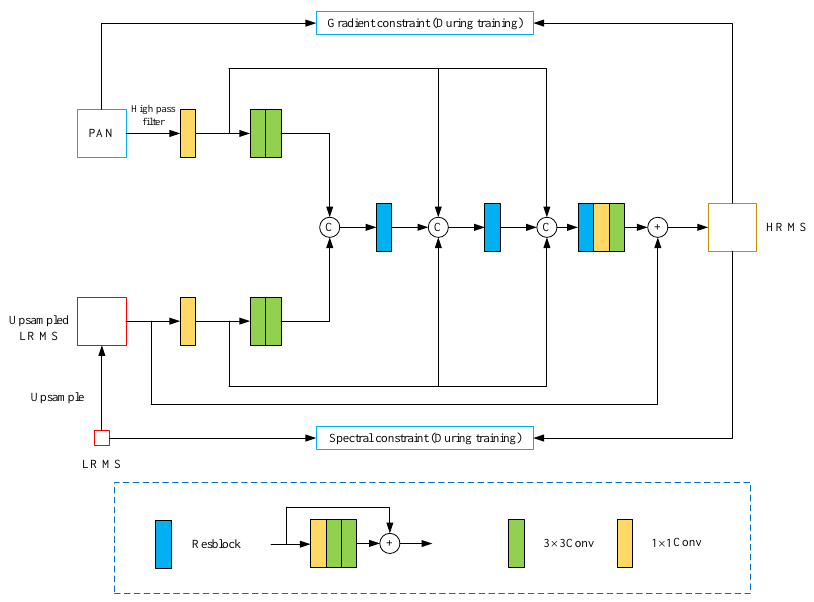
Figure 1. The framework of the proposed